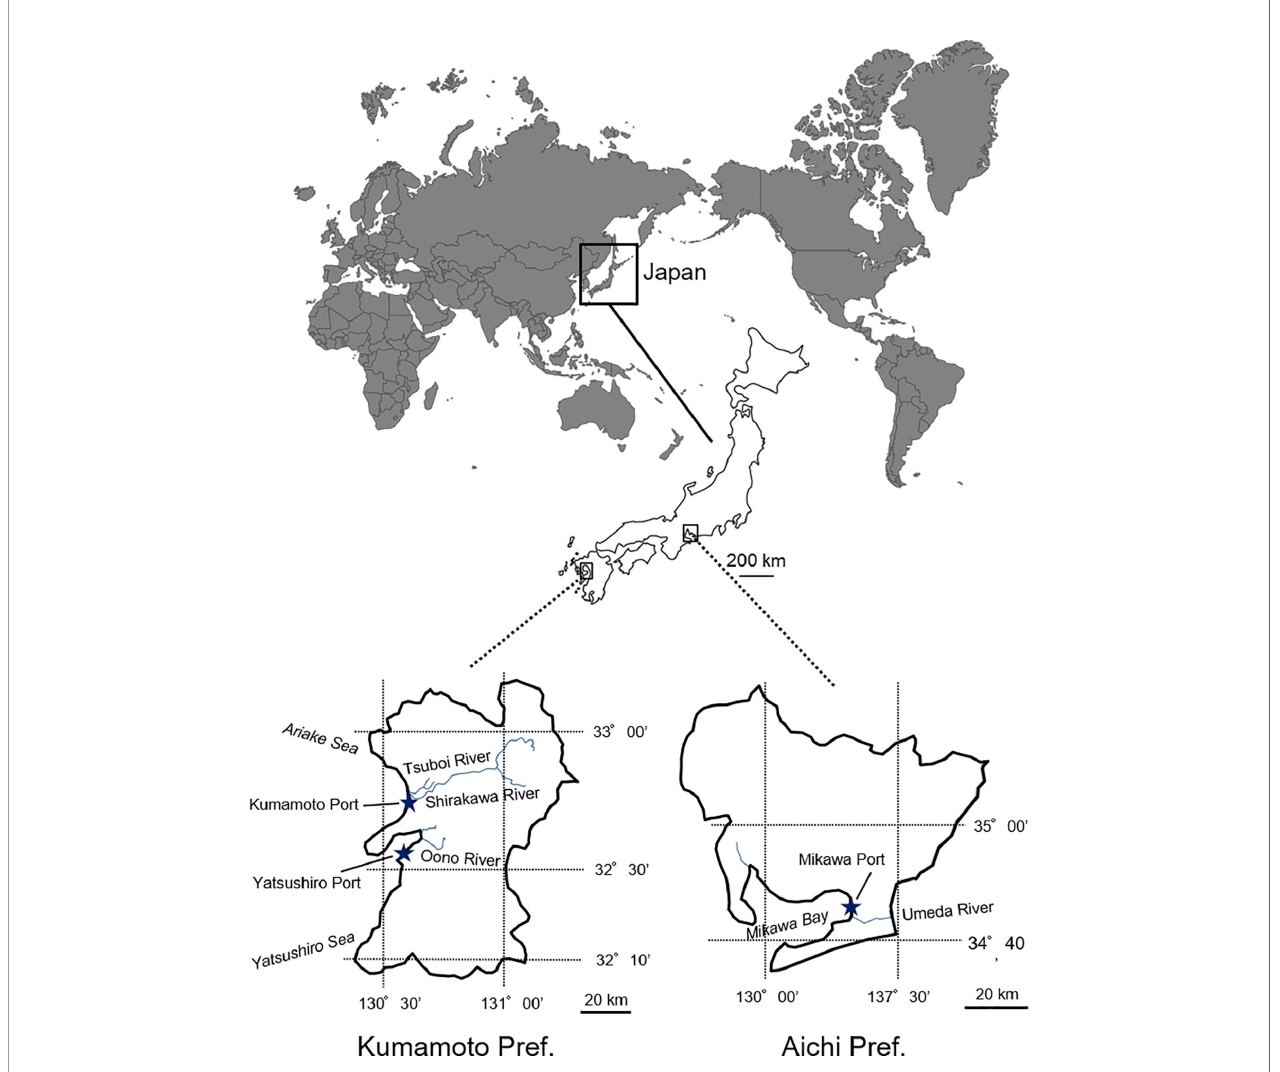
FIGURE 1 | Invasion areas (Aichi and Kumamoto Prefectures) of invasive Spartina alterni fl ora in